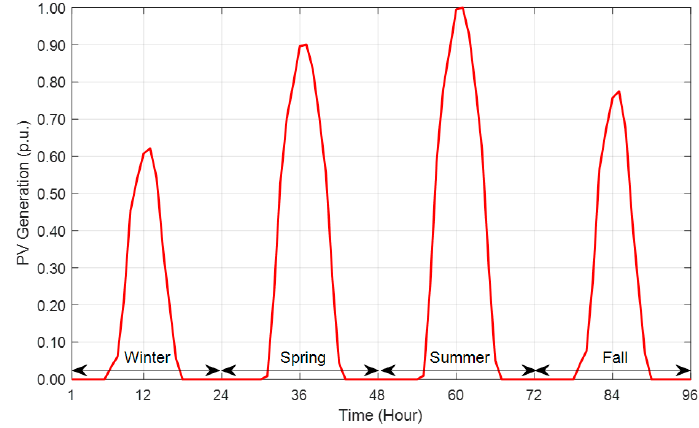
Figure 2. The seasonal variation of PVDG output power.